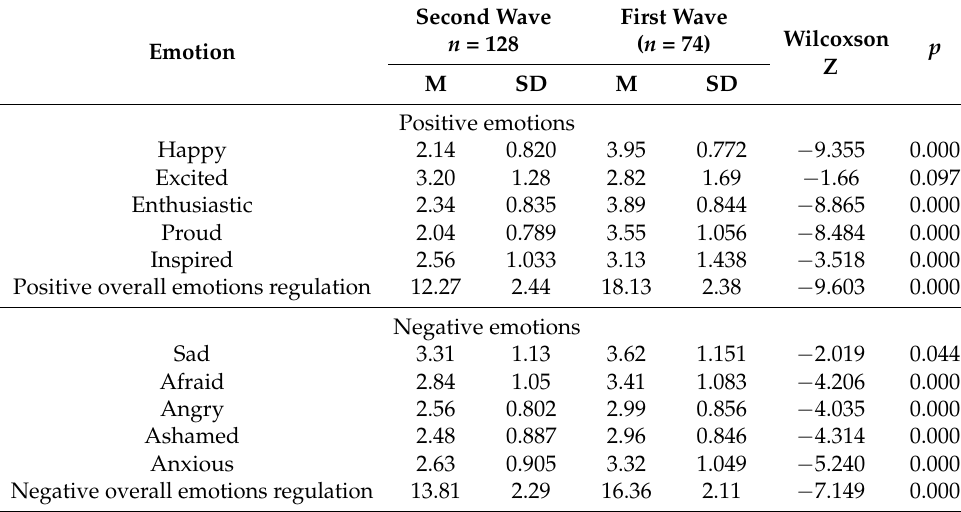
Table 2. Data on emotions regulation difficulties after the first and second